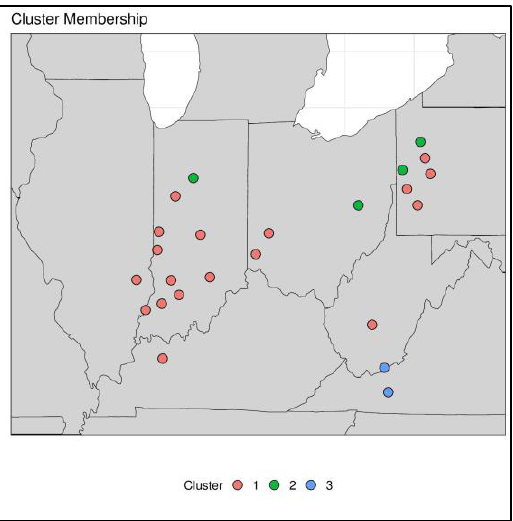
Figure A2. Cluster membership using hierarchical clustering across all the stream-gauges.